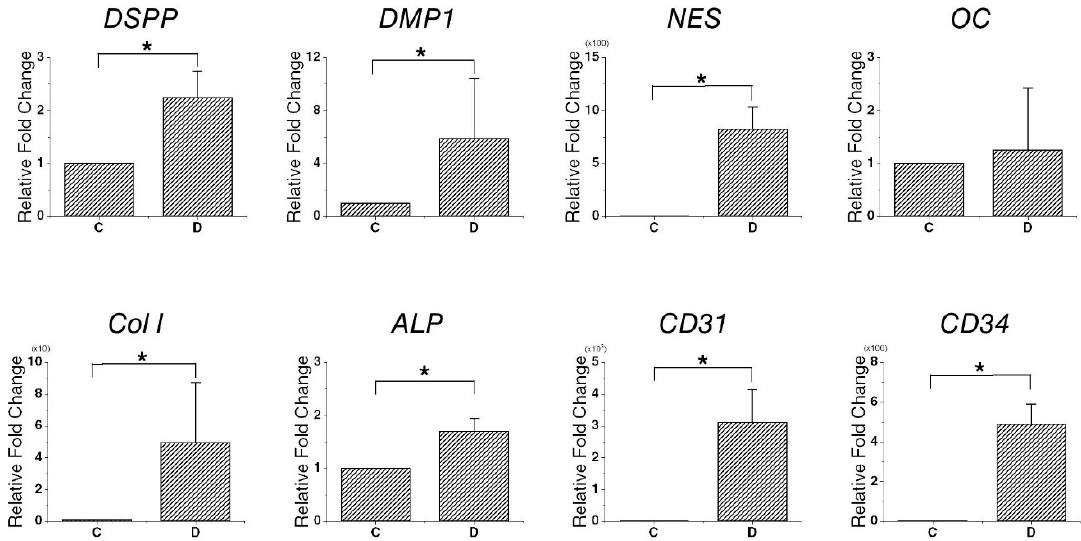
Figure 6. Relative expression levels of the genes encoding DSPP , DMP1 , NES , OC , Col I , ALP , CD31 , and CD34 in dHDP